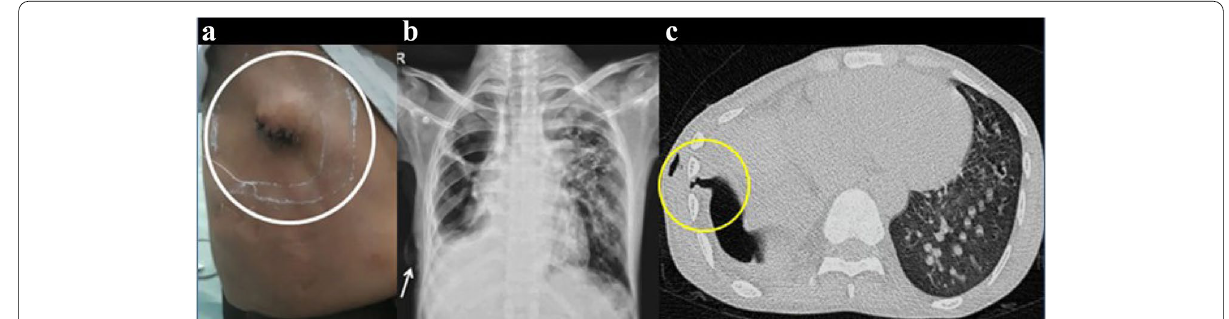
Fig. 2 a A soft reducible mass, prominent on coughing, valselva noted at the site of previous intercostals drainage with overlying sutures. b Chest radiograph (A-P) view showing the presence of a tongue of herniated lung tissue at the right base overlying the herniated tissue. c CT chest showing the cicatricial collapse of the right lung, tractional bronchiectatic changes in the left lung with cavities in bilateral lungs, and presence of aspergilloma in the left apical region with features of pulmonary arterial hypertension. Pleural dehiscence with lung herniation is seen in the right